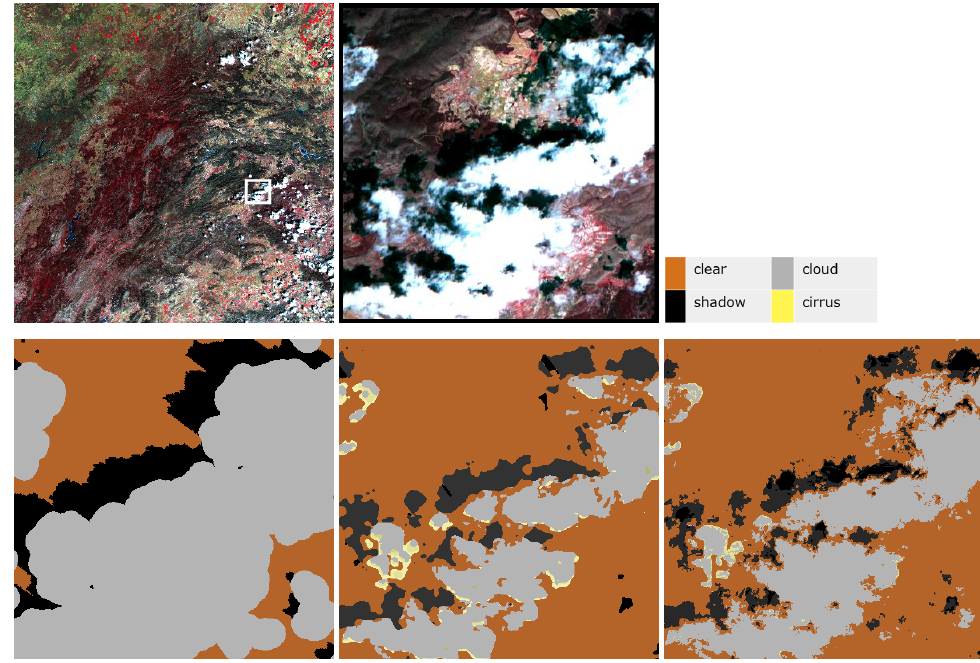
Figure 6. Top row (left to right): CIR (RGB = 865,665,560 nm) composite and CIR subset of scene ID 18 (Barrax-2). Bottom row (left to right): Fmask, ATCOR and Sen2Cor classification maps of the